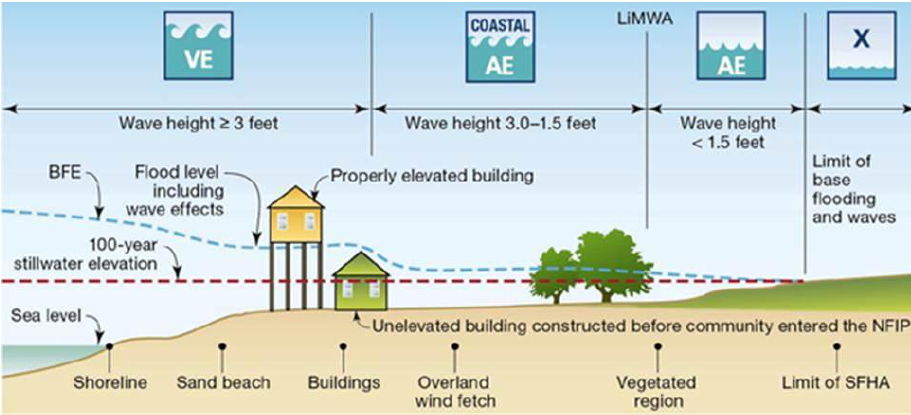
Figure 2. FEMA definition schematic for flooding and structures located on grade and elevated [6]. The still water elevation (SWEL) for 1% annual chance (100 year) is shown in the dashed red line and the Base Flood Elevation (BFE) in the blue dashed line. FEMA zones (VE, AE seaward and landward of the Limit of Moderate Wave Action (LiMWA)), based on wave heights, are also noted at the top of the figure.